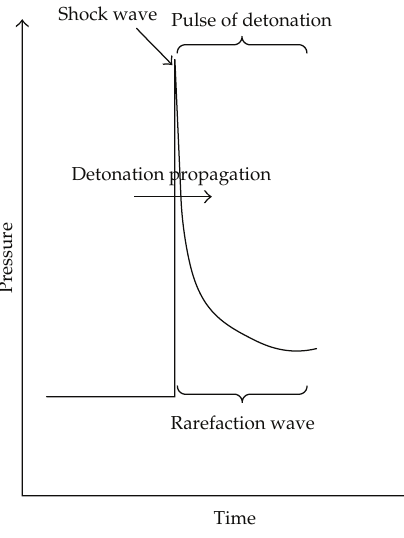
Figure 2: Structure of the pulse detonation.